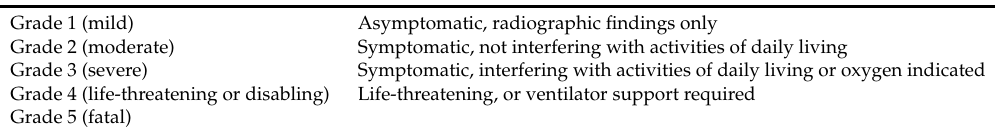
Table 1. Grading of drug-induced interstitial lung disease (DIILD) based on the National Cancer Institute Common Terminology Criteria for Adverse Events